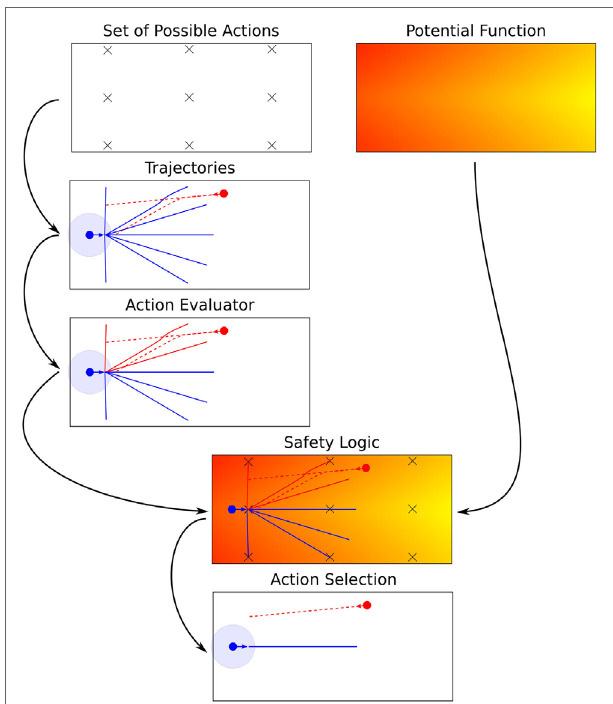
FigUre 3 | Example of how an intelligent robot running a CE chooses the best action from the set of possible actions and the base values using the AE and SL. The panel Potential Function depicts a color coded rendition of the example potential function. Furthermore, the panel Set of Possible Actions depicts the discretization of space employed. The simulated trajectories for all actions in the set of possible actions generated by the internal simulator are depicted in the panel Trajectories . The trajectories of the intelligent robot are depicted as solid blue lines and the ones of the other robot as red dashed lines, respectively. Because of the finite time simulated ahead, the trajectories of the intelligent robot do not reach the designated targets of the actions for the three most distant targets. Note that the trajectories of the other robot are identical for most of the actions, which is the case if the two robots do not interact, so the lines lie exactly on top of each other. The panel Action Evaluator depicts the evaluation of the trajectories by the AE by coloring the trajectories red for which a safety violation is detected. The SL combines the results of the AE with the PF, which is represented graphically by overlaying the corresponding panels in Safety Logic . The last panel Action Selection depicts the action selected for execution by the AS of the robots by only showing the corresponding trajectories of the two